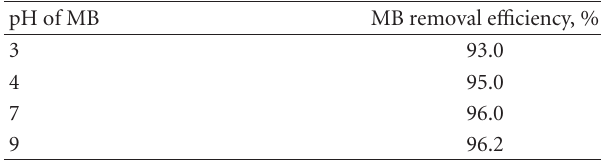
Table 5: E ff ect of pH of MB solution on MB removal e ffi ciency.